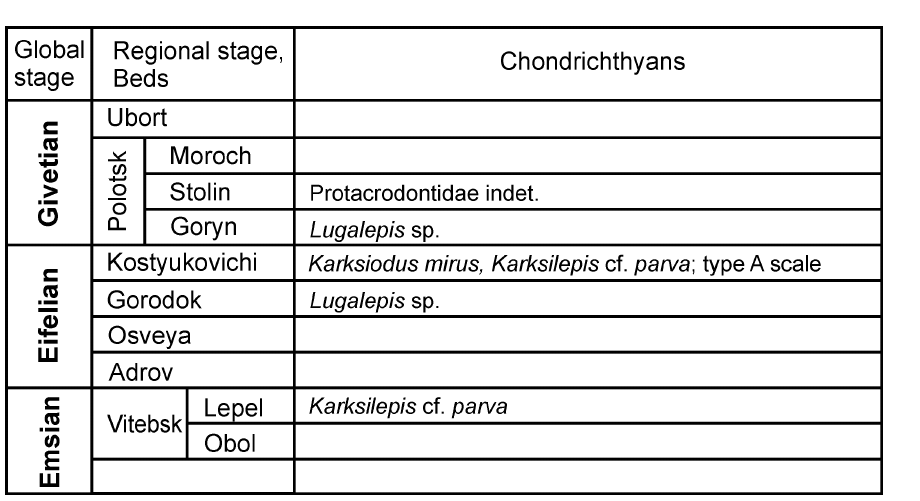
Fig. 6. Distribution of chondrichthyans in the Lower and Middle Devonian of Belarus (stratigraphic chart after Kruchek et al. 2010).